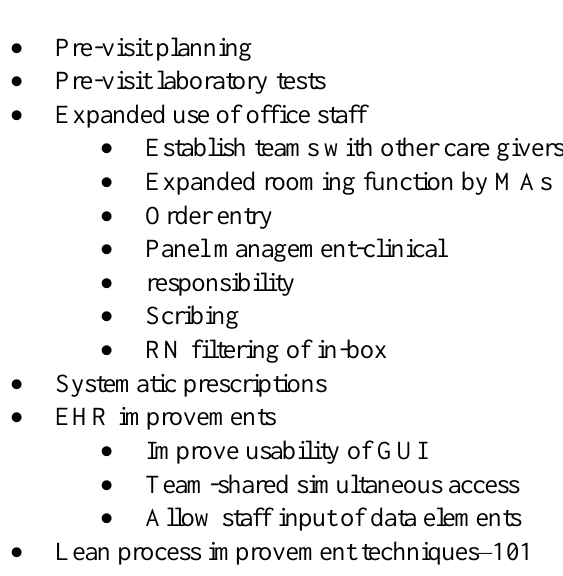
Physician practice support